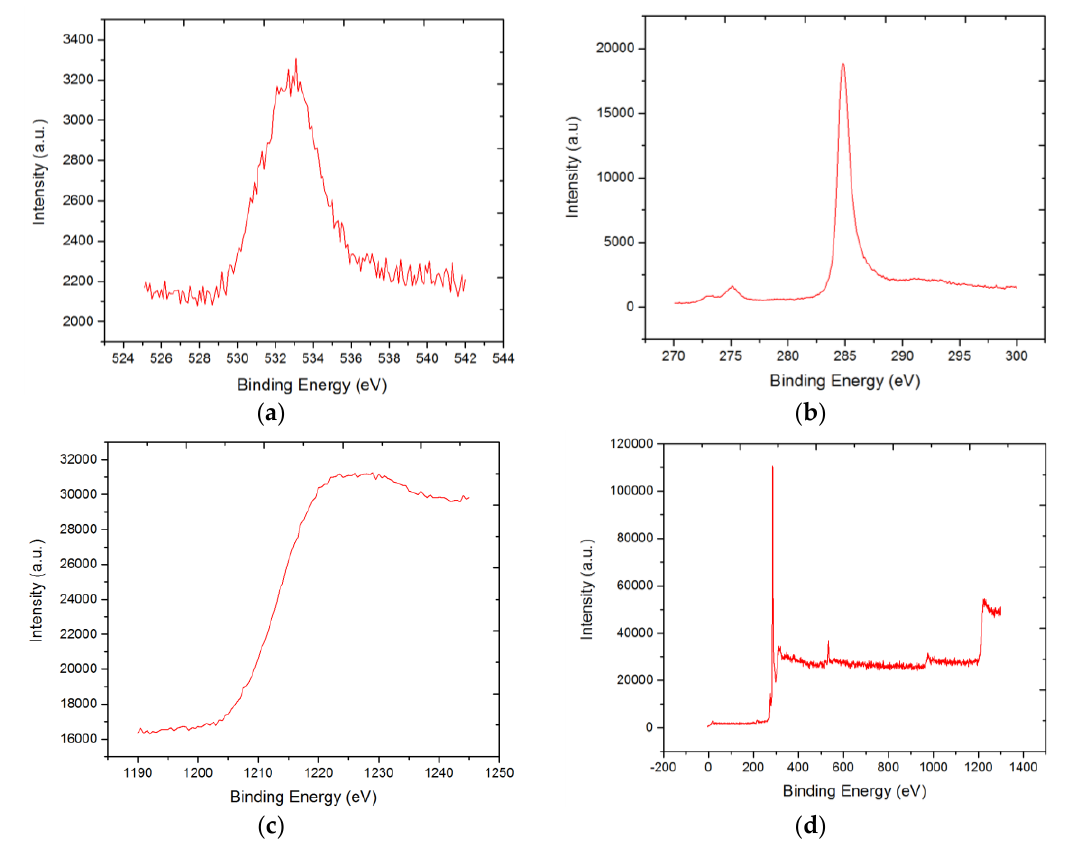
Figure 3. X-ray photoelectron spectroscopy (XPS) analysis of graphene nanosheets. ( a ) O 1s spectrum peak position: 532.8 eV. The sample consists of about 3% oxygen. There is approximately 3% oxygen within the sample; ( b ) C 1s spectrum peak position: 284.8 eV. ( c ) High binding energy featured at about 290 eV. This data confirms the C Auger region. The D parameter is found to be 21 eV, verifying the presence of pure sp 2 carbon. ( d ) XPS characterization of GNS raw data 284.8 eV shows C 1s spectrum, the O 1s spectrum peaks position is at 532.8 eV, the ~1000 eV peaks come from oxygen.